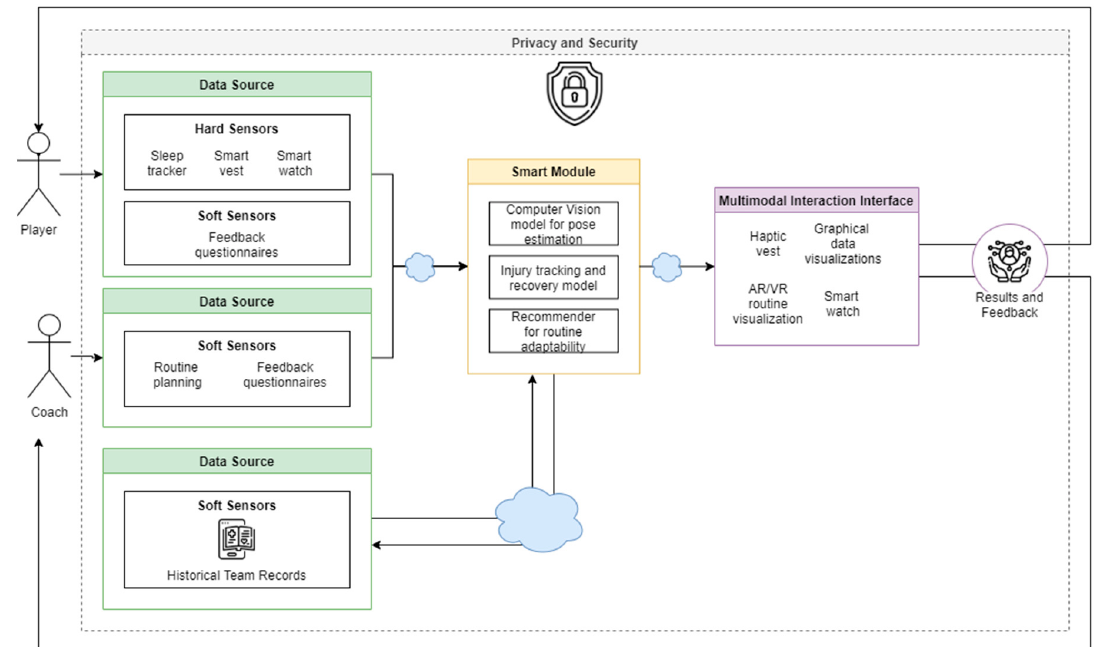
Figure 4. DTCoach System.